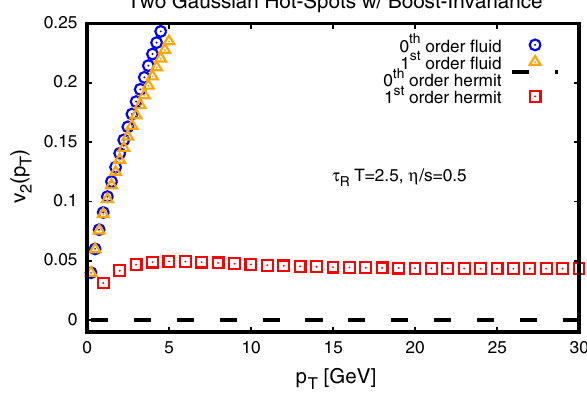
Fig. 3 Parton elliptic flow v 2 ( p T ) as a function of particle transverse momentum p T for two boost-invariant Gaussian hot-spots initially located at x = ± σ with σ = 0 . 4 fm. Shown are results for zeroth and first order hydrodynamic gradient expansion as well as zeroth and first order eremitic expansion, for τ R T = 2 . 5 (corresponding to η